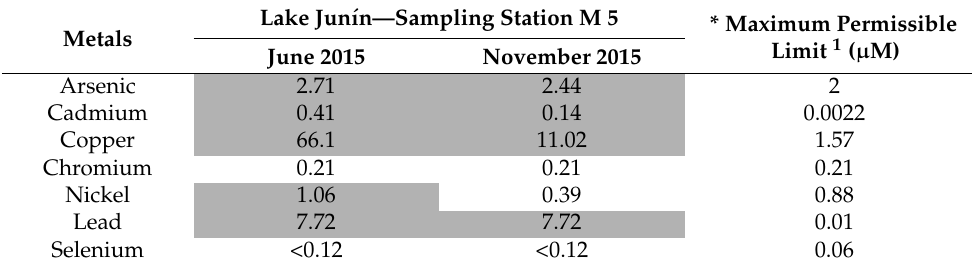
Table 2. Heavy metal concentrations in water samples from Jun í n